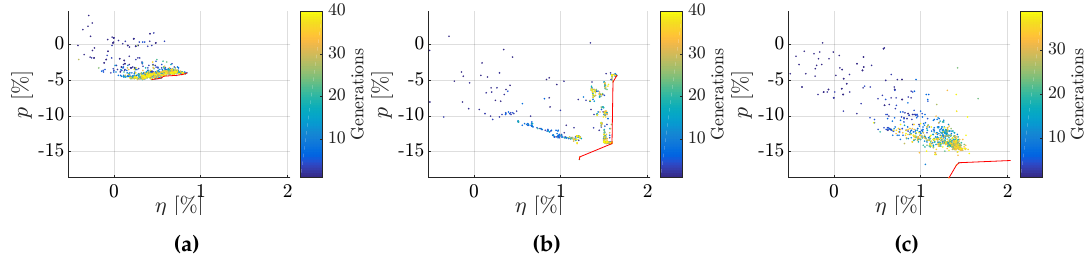
Figure 14. Pareto front in objective space for initial set-ups of opt-11-10 ( a , b ) and final set-up ( c